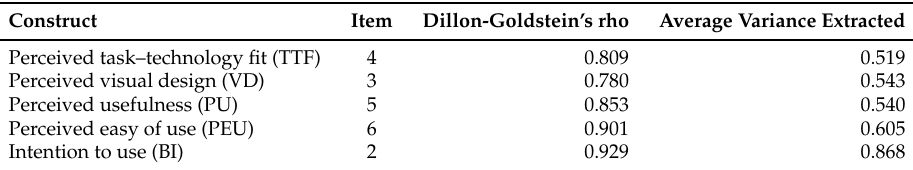
Table 4. Internal consistency and convergent